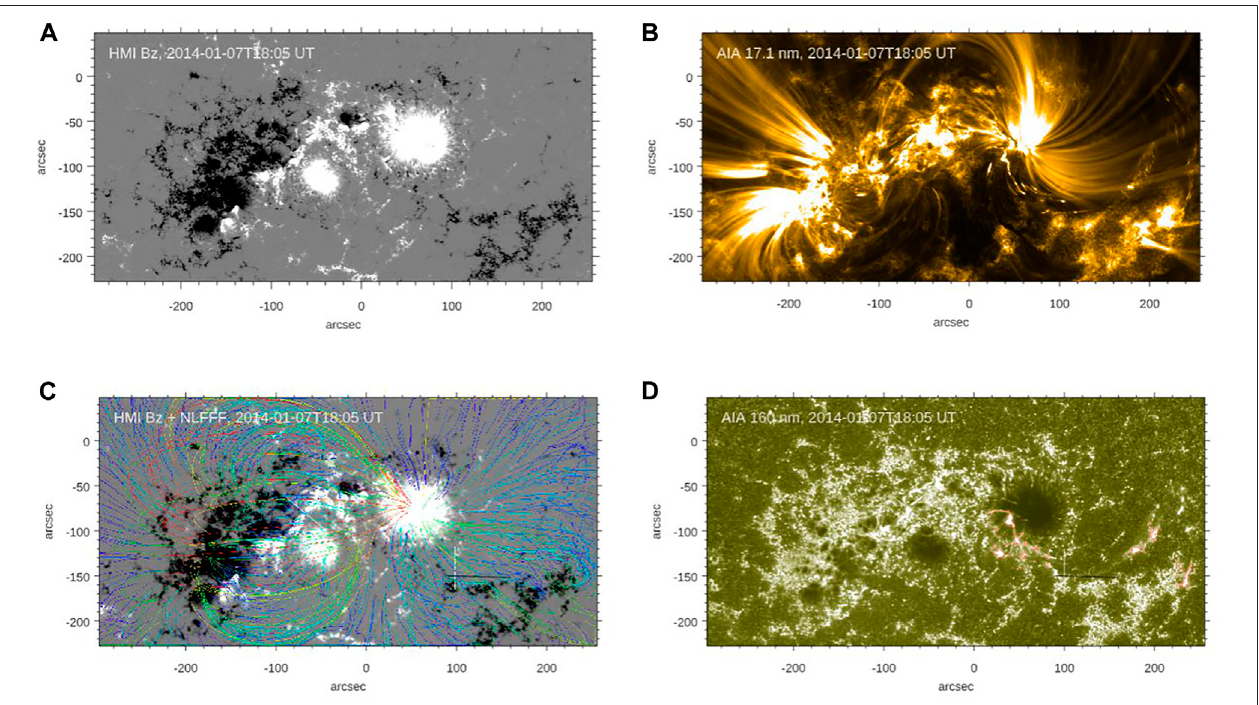
FIGURE 1 | NOAA AR 11944 as it appeared in an HMI magnetogram (A) as well as AIA 17.1 and 160 nm imaging data (B,D) on 7 January 2014 at 18:05 UT. The (C) shows the same HMI magnetogram overplotted with the results of magnetic fi eld extrapolation. Color coding of fi eld lines indicates their length (blue — shortest, red —